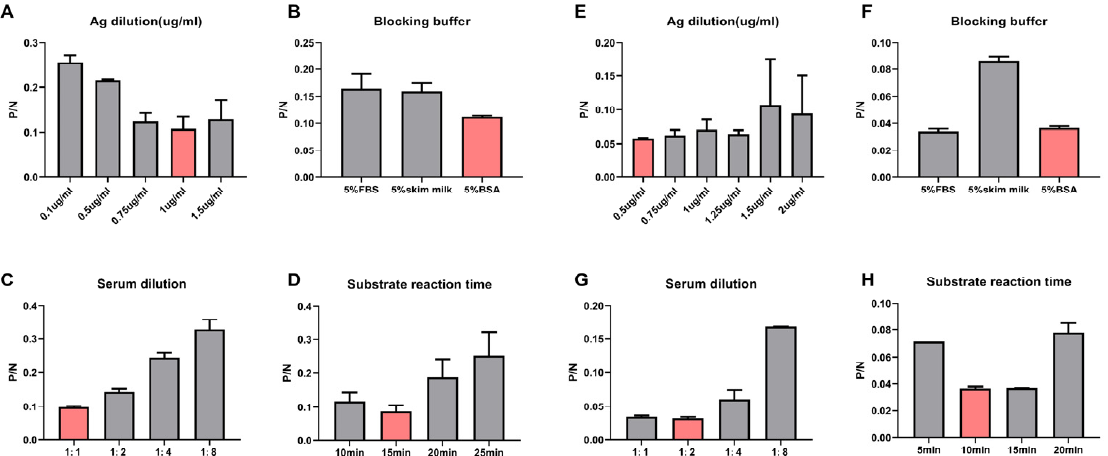
Figure 1. Determination of optimal antigene dilution, blocking buffer, serum dilution, and substrate reaction time. Determination of concentrations of EMA1 protein ( A ), blocking buffer ( B ), serum dilution ( C ), and substrate reaction time ( D ) to be used in the novel cELISA to detect antibodies against T. equi. Determination of concentrations of Bc48 protein ( E ), blocking buffer ( F ), serum dilution ( G ), and substrate reaction time ( H ) to be used in the novel cELISA to detect antibodies against B. caballi.